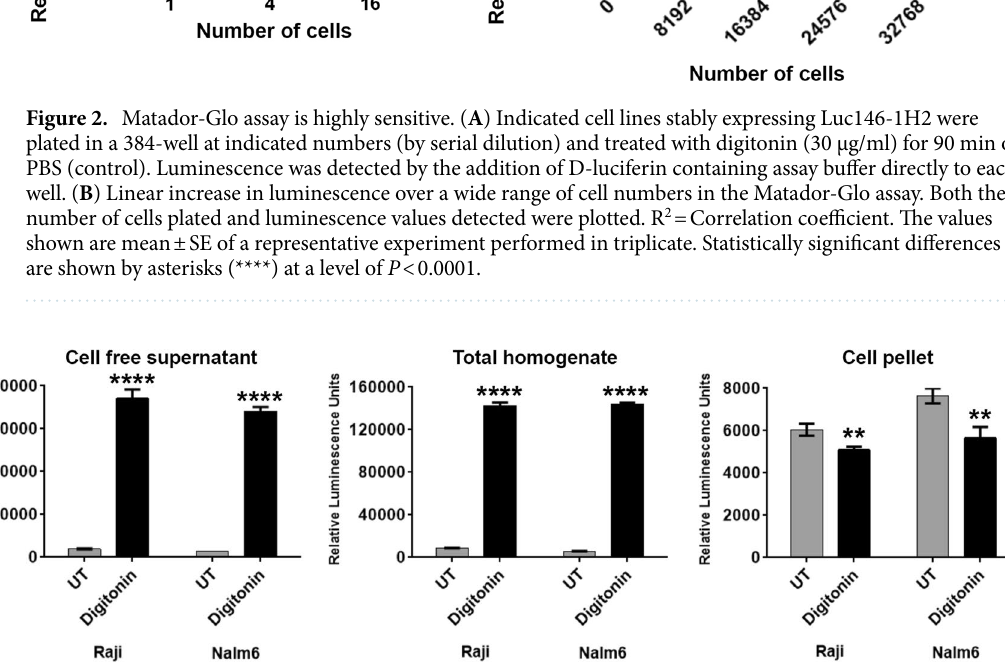
Figure 3. The Matador-Glo assay is a single-step homogenous assay. Raji/Nalm6 cells stably expressing Luc146-1H2 were either left untreated (UT) or treated with 30 μg/ml digitonin to induce cell death. Post- treatment, the cells were mixed well, collected in a 1.5 ml microfuge tubes and divided into 3 sets. Set 1 (cell-free supernatant), cells were centrifuged, and cell supernatants alone were collected in a new tube and plated in a 384-well plate, followed by measuring the luciferase activity. Set 2 (total homogenate), the cells with supernatant were directly assayed for luciferase activity by plating in a 384-well plate. For set 3 (cell pellet), cells were centrifuged, supernatant was removed, followed by the resuspension of cell pellets in PBS and plated in a 384- well plate to assess luciferase activity. Total reaction volume plated in 384-well plate from three sets was kept constant at 60 µl per well, and 15 µl of D-luciferin assay buffer was added in well mode to measure luciferase activity. The values shown are mean ± SE of a representative experiment performed in triplicate. Statistically significant differences are shown by asterisks (**) at a level of P < 0.01 and (****) at a level of P <